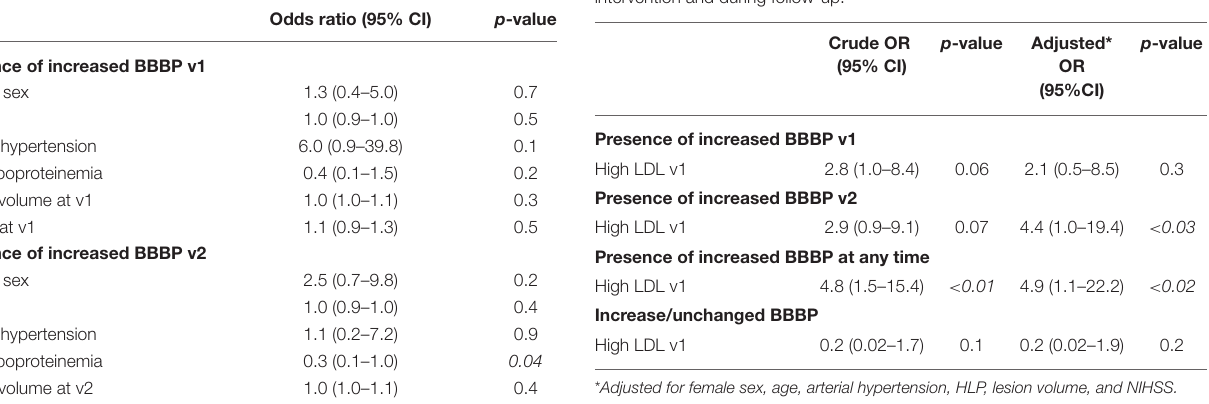
TABLE 5 | Multivariate regression analyses of elevated low-density lipoprotein (LDL) levels before (v1) intervention with presence of increased BBBP before intervention and during